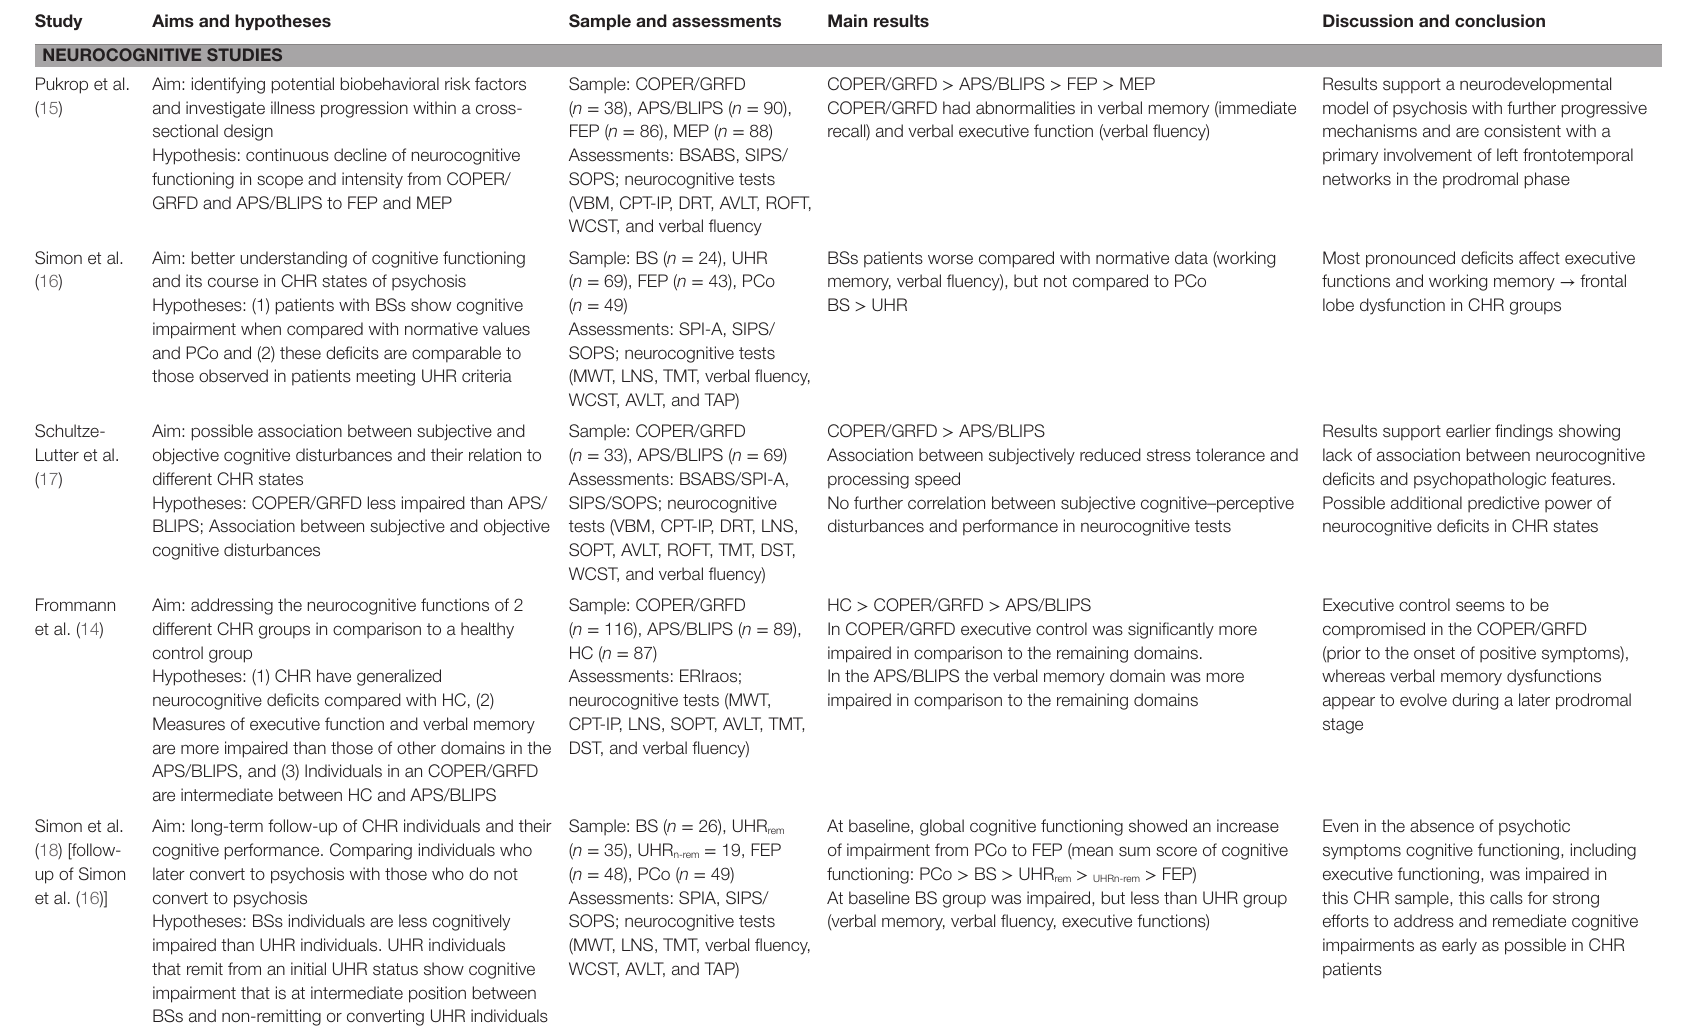
tABLe 2 | summary of neurobiological studies of basic